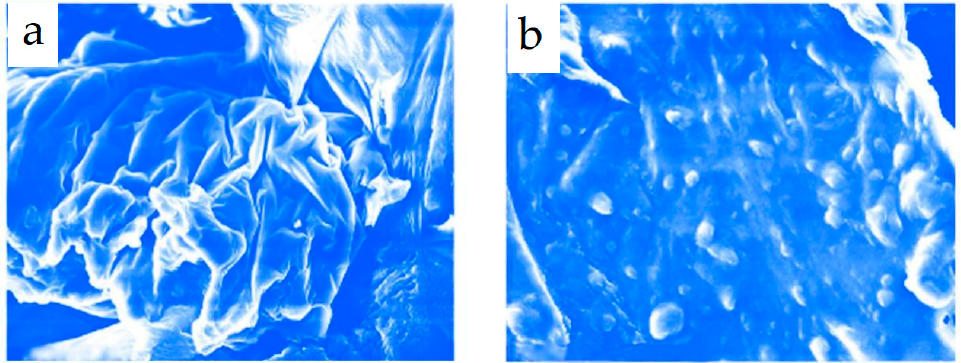
Figure 3. StructureofparaffincrystalsusingSEMmicroscopy: ( a )—beforesonication, ( b Figure 3. Structure of para ffi n crystals using SEM microscopy: ( a )—before sonication, ( b )—after sonication.